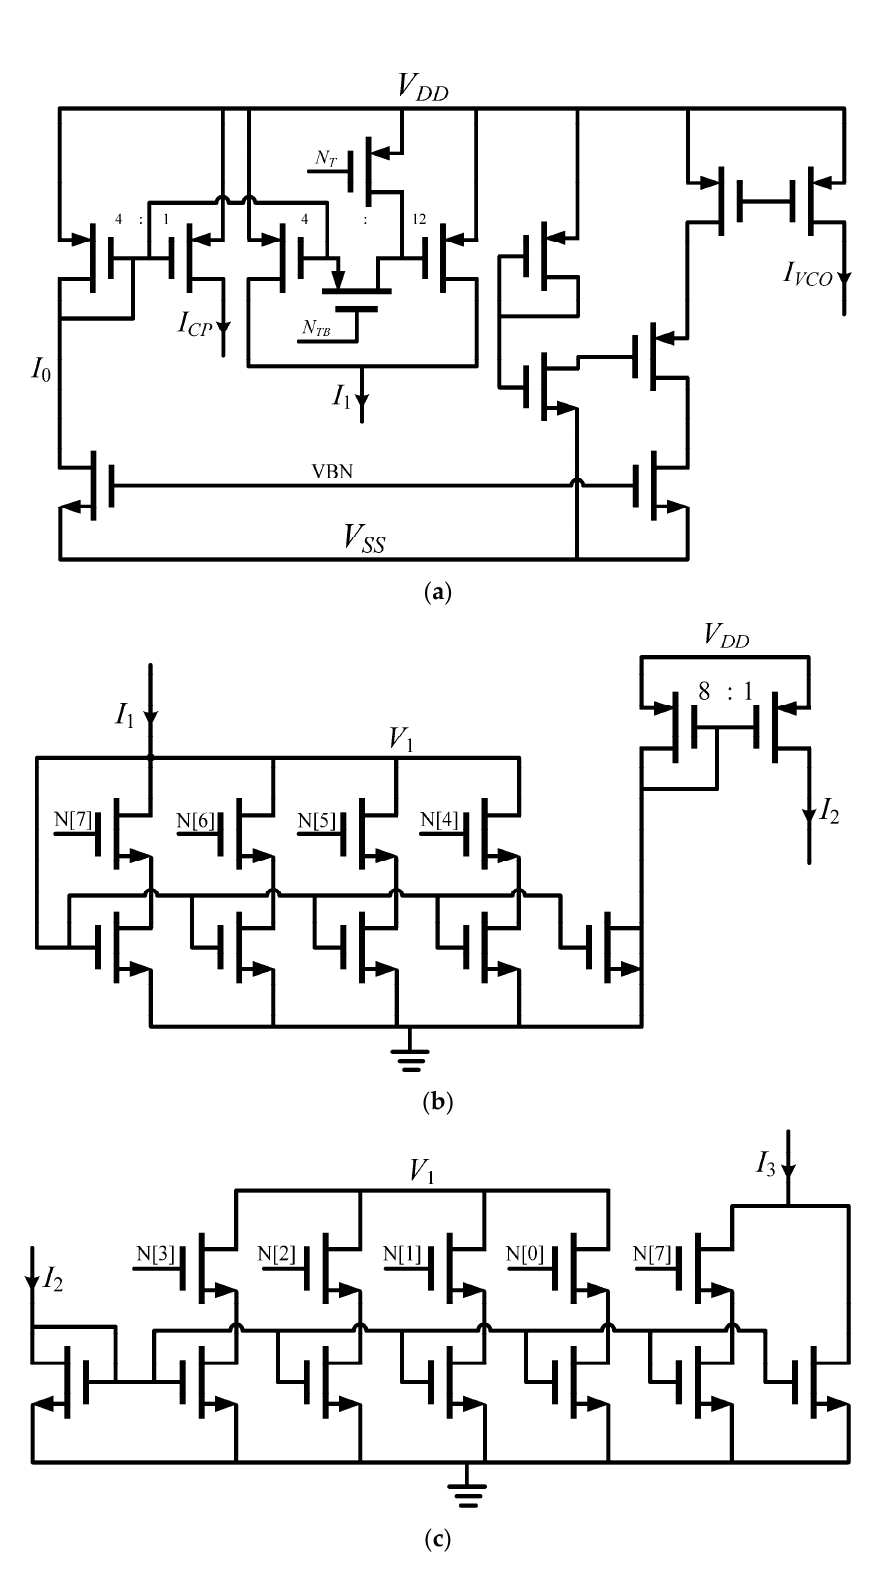
Figure 3. The proposed self-biased circuit: ( a ) The current of the circuit is related to the tuning voltage of the VCO; ( b ) The current of the circuit is related to the upper four bits of the control word of the frequency divider; ( c ) The current of the circuit is related to the lower four bits of the control word of the frequency